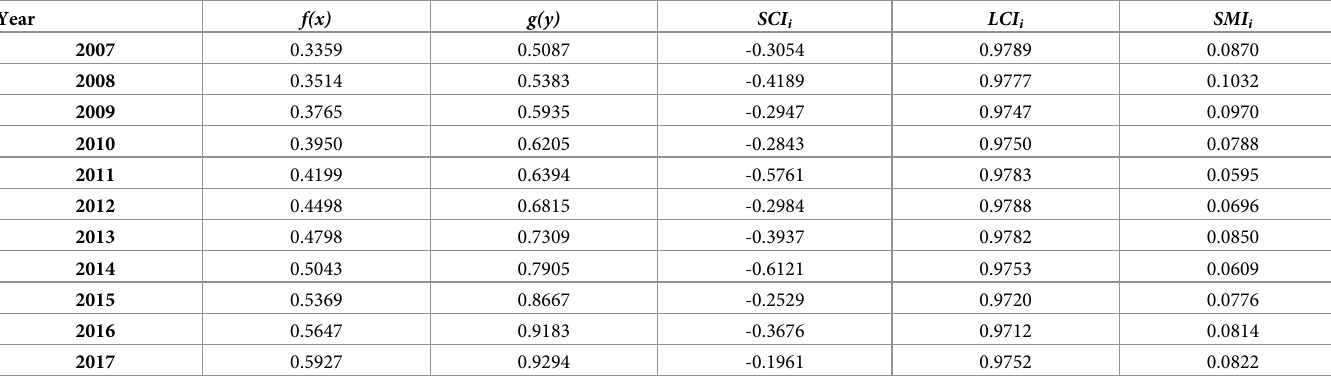
Table 3. MDCE of population-land urbanization in the YEB from 2007 to